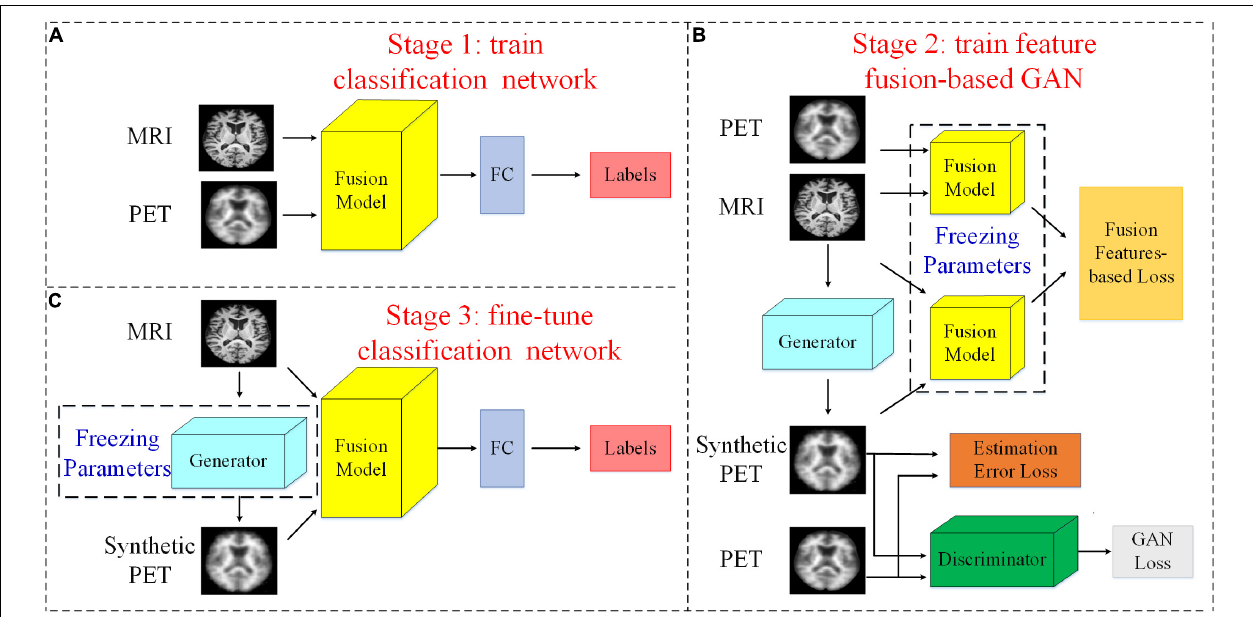
FIGURE 1 | Flowchart of our study. (A) Stage 1: We pretrain the classification network with both MRI and PET images and their corresponding labels. (B) Stage 2: The feature fusion-based GAN is trained using the fusion model that is composed of all layers except the FC layer of the classification network. (C) stage 3: We use the real MR images, synthesized PET images, and their corresponding labels to fine-tune the classification model. Here, we assume that the PET images are missing and use the generator to synthesize